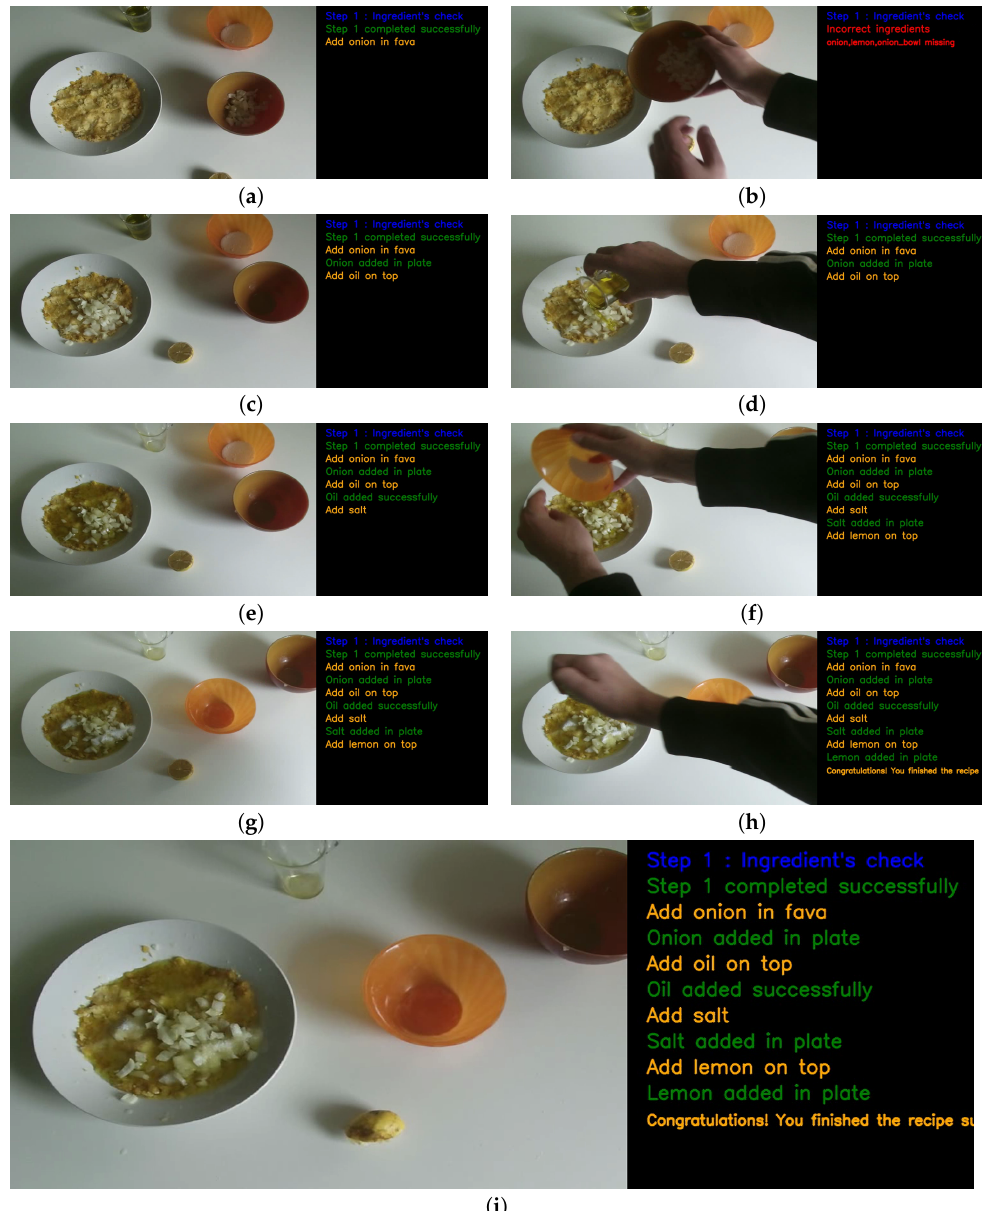
Figure 13. Cooking procedure of fava: ( a ) first step: add onion, ( b ) moving onion; ( c ) second step: add oil, ( d ) moving oil; ( e ) third step: add salt, ( f ) moving salt; ( g ) fourth step: add lemon, ( h ) moving lemon; ( i ) successful execution of the